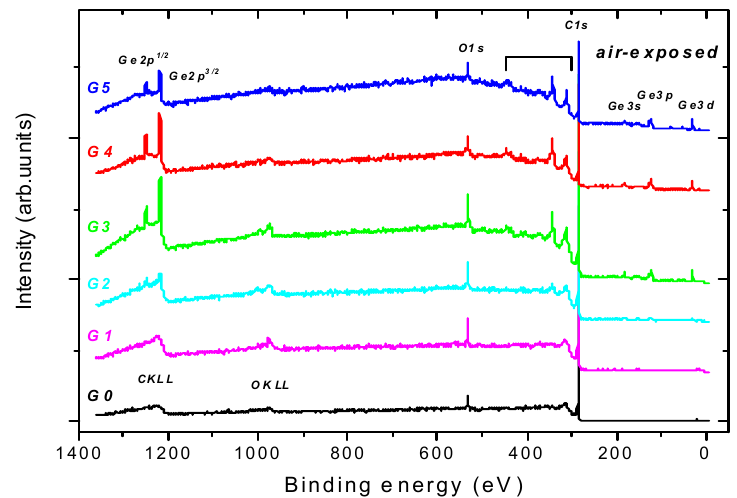
Figure 1. Typical photoelectron survey spectra recorded at normal electron emission angle from the surface of the undoped diamond-like carbon G0 and Ge-doped samples G1-G5. The samples labelling is introduced in Table 1. Table 1. Apparent XPS composition data recorded from the undoped DLC and Ge-doped DLC layers. The surface-related contents of the Ge derived from the XPS spectra is compared with the bulk-like values derived from the WDS spectra [20]. The C sp 2 and C sp 3 fractions originate from a peak-fitting of the C 1s line, which will be introduced below.